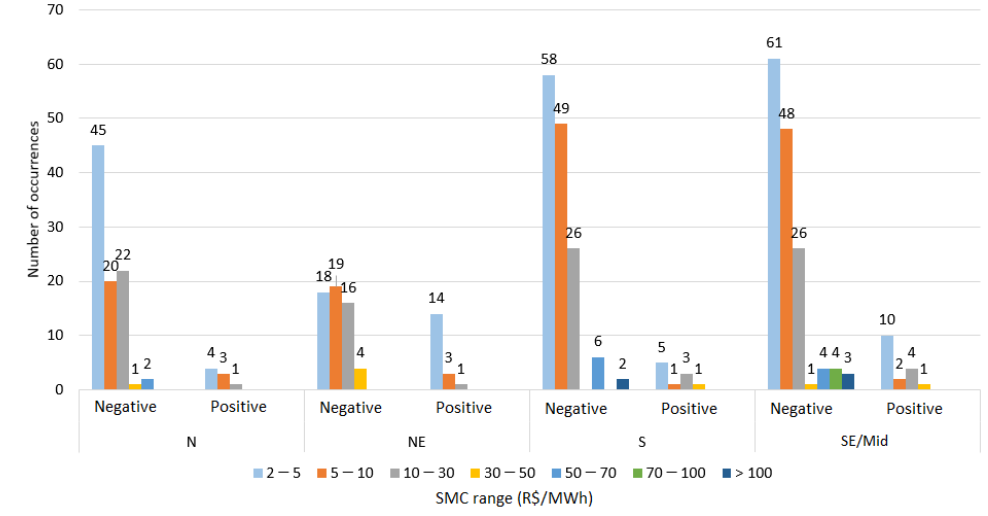
Figure 8. Occurrences of SMC values—positive and negative differences.